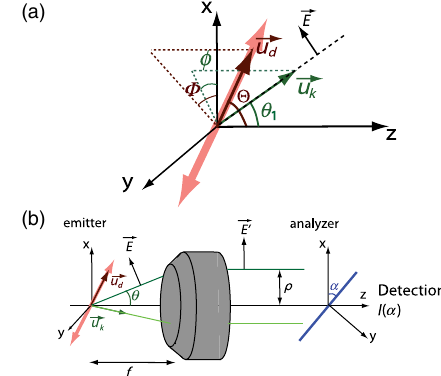
FIG. 1. (a) Schematic of a normalized dipole ~u d with in-plane angle Φ and off-axis angle Θ and a normalized wave vector ~u k with in-plane angle ϕ and off-axis angle θ 1 . (b) Schematic of the simulated situation: the dipole described above, a microscope objective, and a polarizer with in-plane angle α